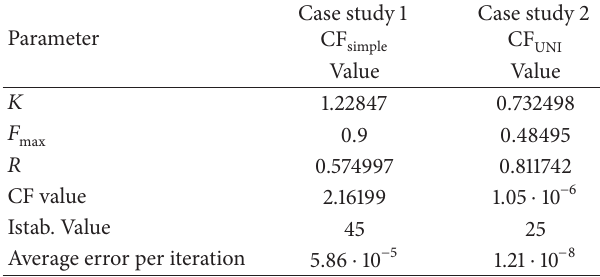
Table 5: Characteristics of the best solution: joined case studies 1 and 2, Burgers map as CPRNG/controlled system.